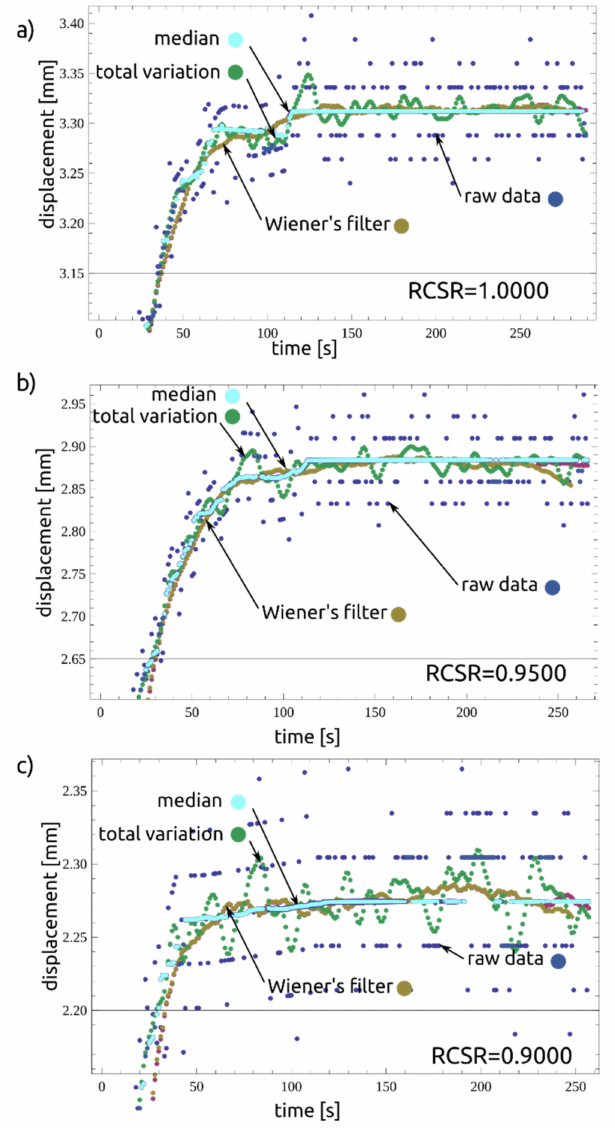
Figure 6. Effect comparison of filters, prepared for ( a ) RCSR = 1.0000, ( b ) RCSR = 0.9500 and ( c ) RCSR = 0.9000.